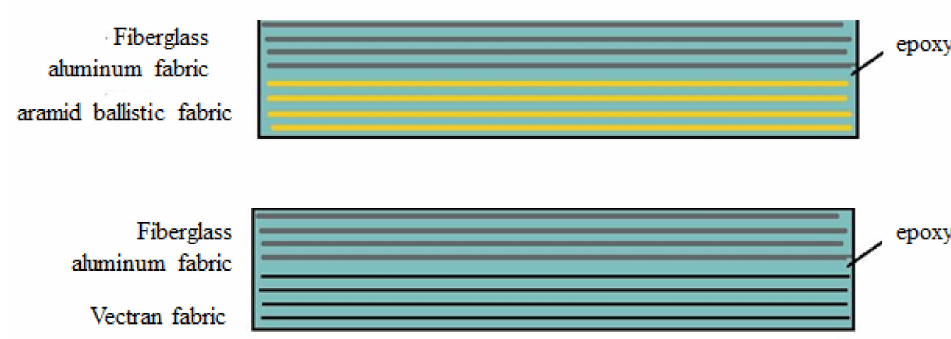
Figure 1. Lay-up of the hybrid composite specimens.